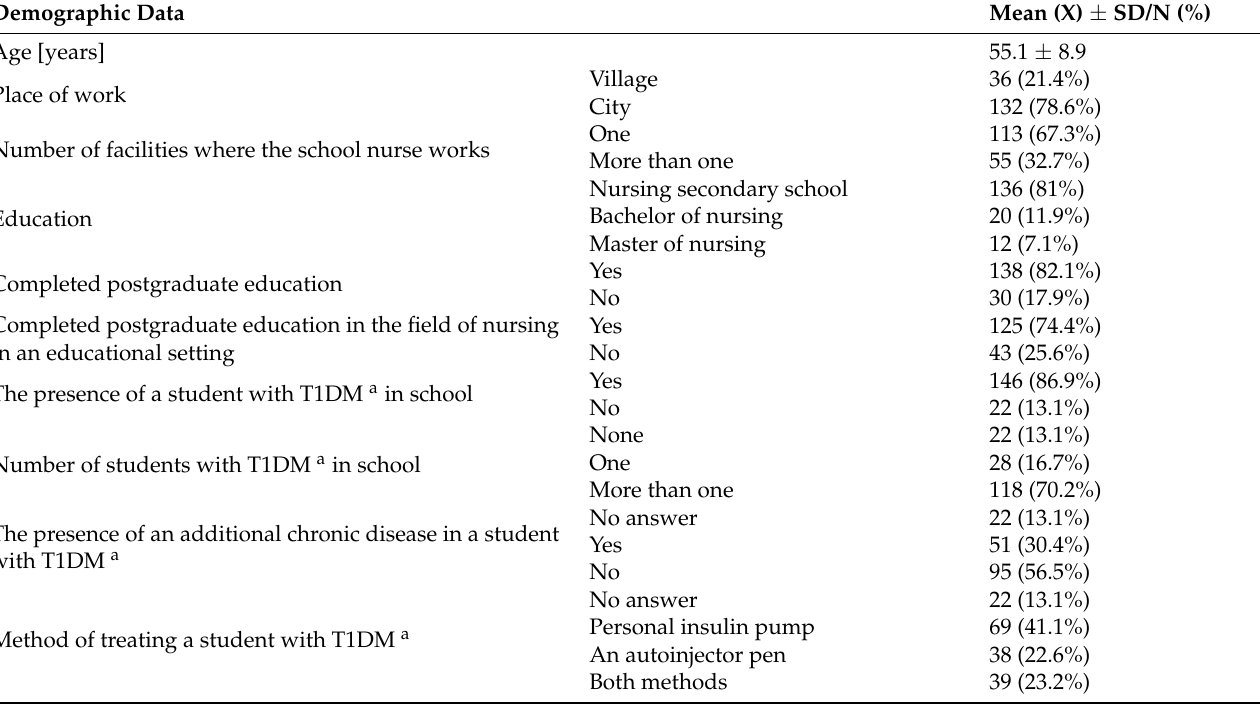
Table 1. Characteristics of school